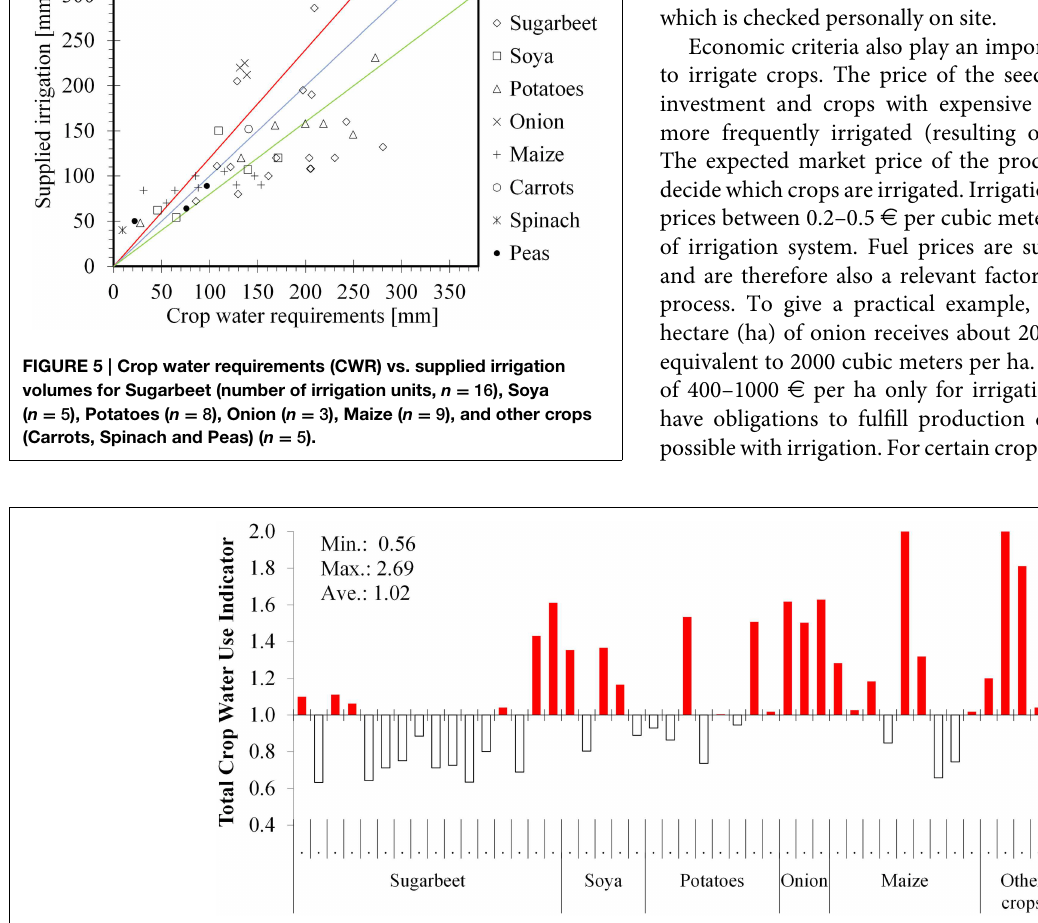
Frontiers in Environmental Science |